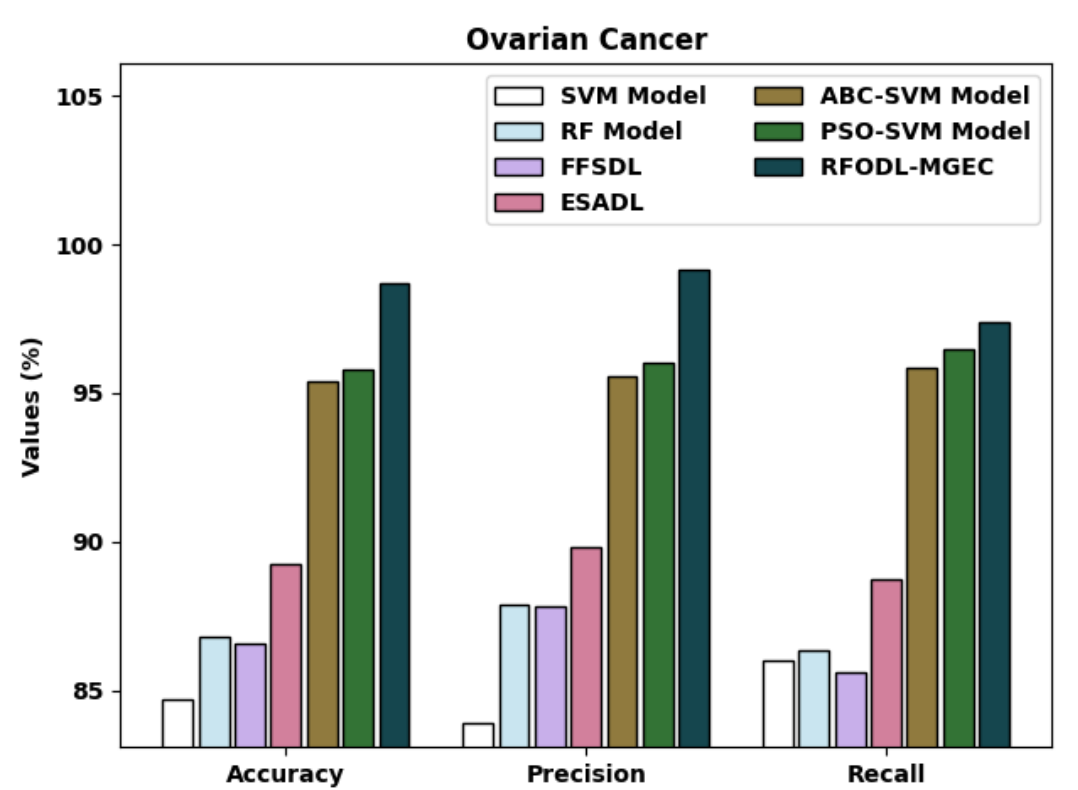
Figure 14. Comparative analysis of RFODL-MGEC technique with ovarian cancer dataset.